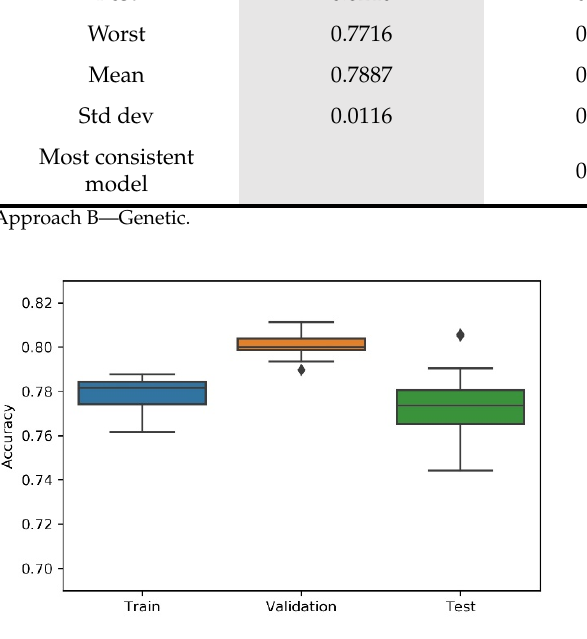
Table 5. Summary table for Approach B—Genetic accuracy (in %).